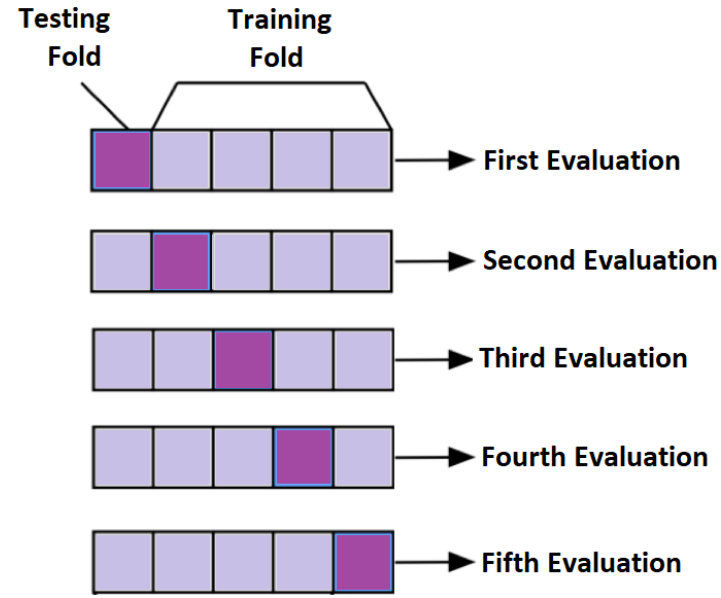
Figure 11. Conceptual Visualization of 5-fold cross